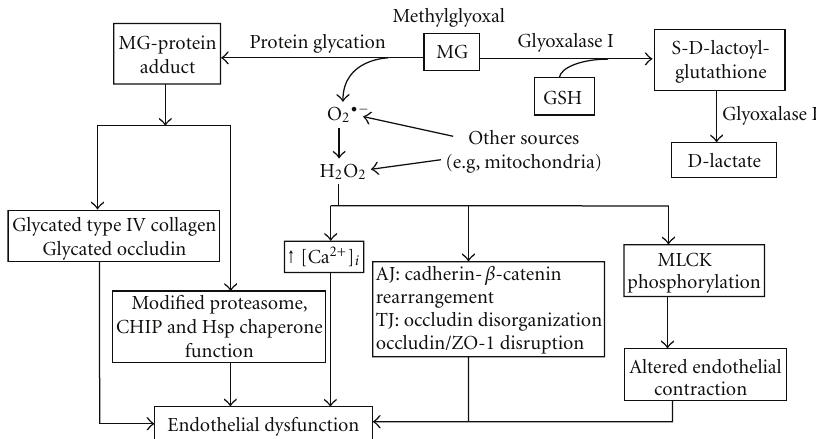
Figure 1: Mechanisms of MG-mediated endothelial barrier dysfunction and its protection by GSH . MG-induced endothelial barrier dysfunction can be caused by MG-protein crosslinking (glycation) resulting in the formation of MG-protein adducts, such as tight junction occludin and basement membrane type IV collagen. MG-protein glycation can also modify the proteasomal and chaperone functions. ROS generated during protein glycation can further mediate barrier dysfunction through various pathways: (a) increased intracellular [Ca 2+ ], (b) direct disruption of adherens junction and tight junction, or (c) phosphorylation of myosin light chain kinase and altered endothelial cell contraction. Protection of barrier integrity is mediated by GSH, which functions as a cofactor in glyoxalase I-catalyzed metabolism